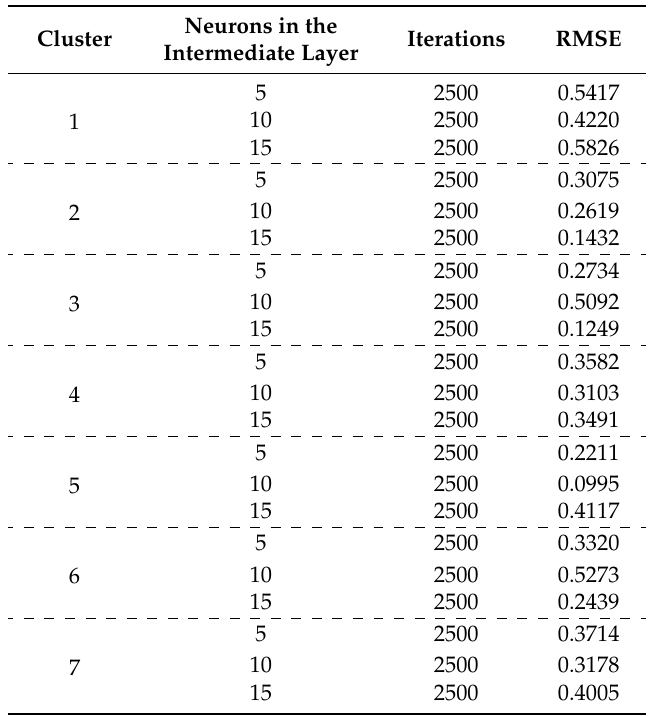
Table 2. Analysis of the performance of the MLP neural